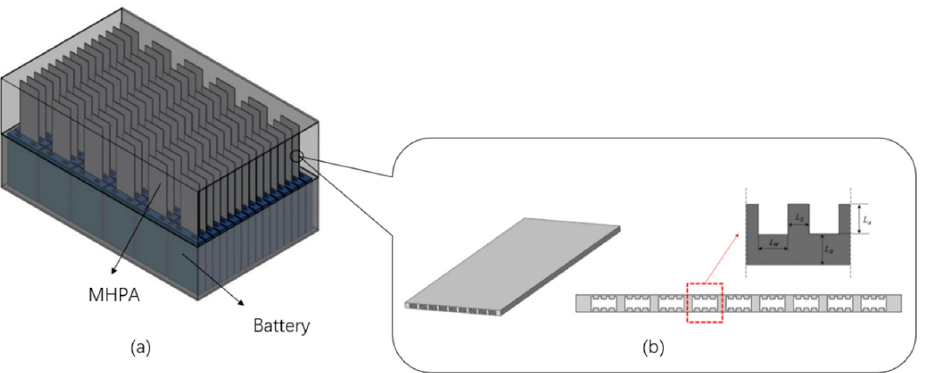
Figure 6. Schematic diagram of the thermal management system of the micro heat pipe array ( a ) the schematic diagram of the combination of the micro heat pipe array and the battery, ( b ) the schematic diagram of the MHPA structure [42]. Reproduced from reference [42] with permission from Elsevier B.V., copyright 2019.